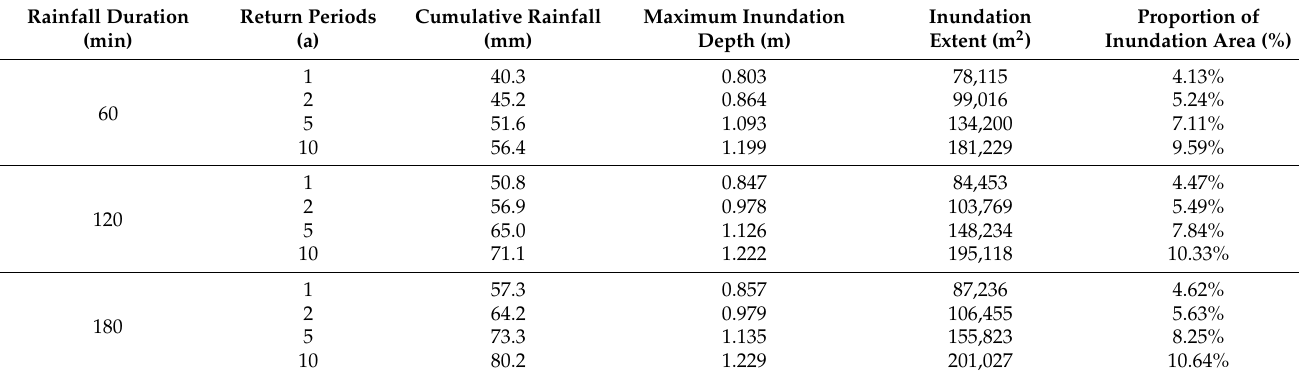
Table 6. The simulation results of different rainfall durations (r =